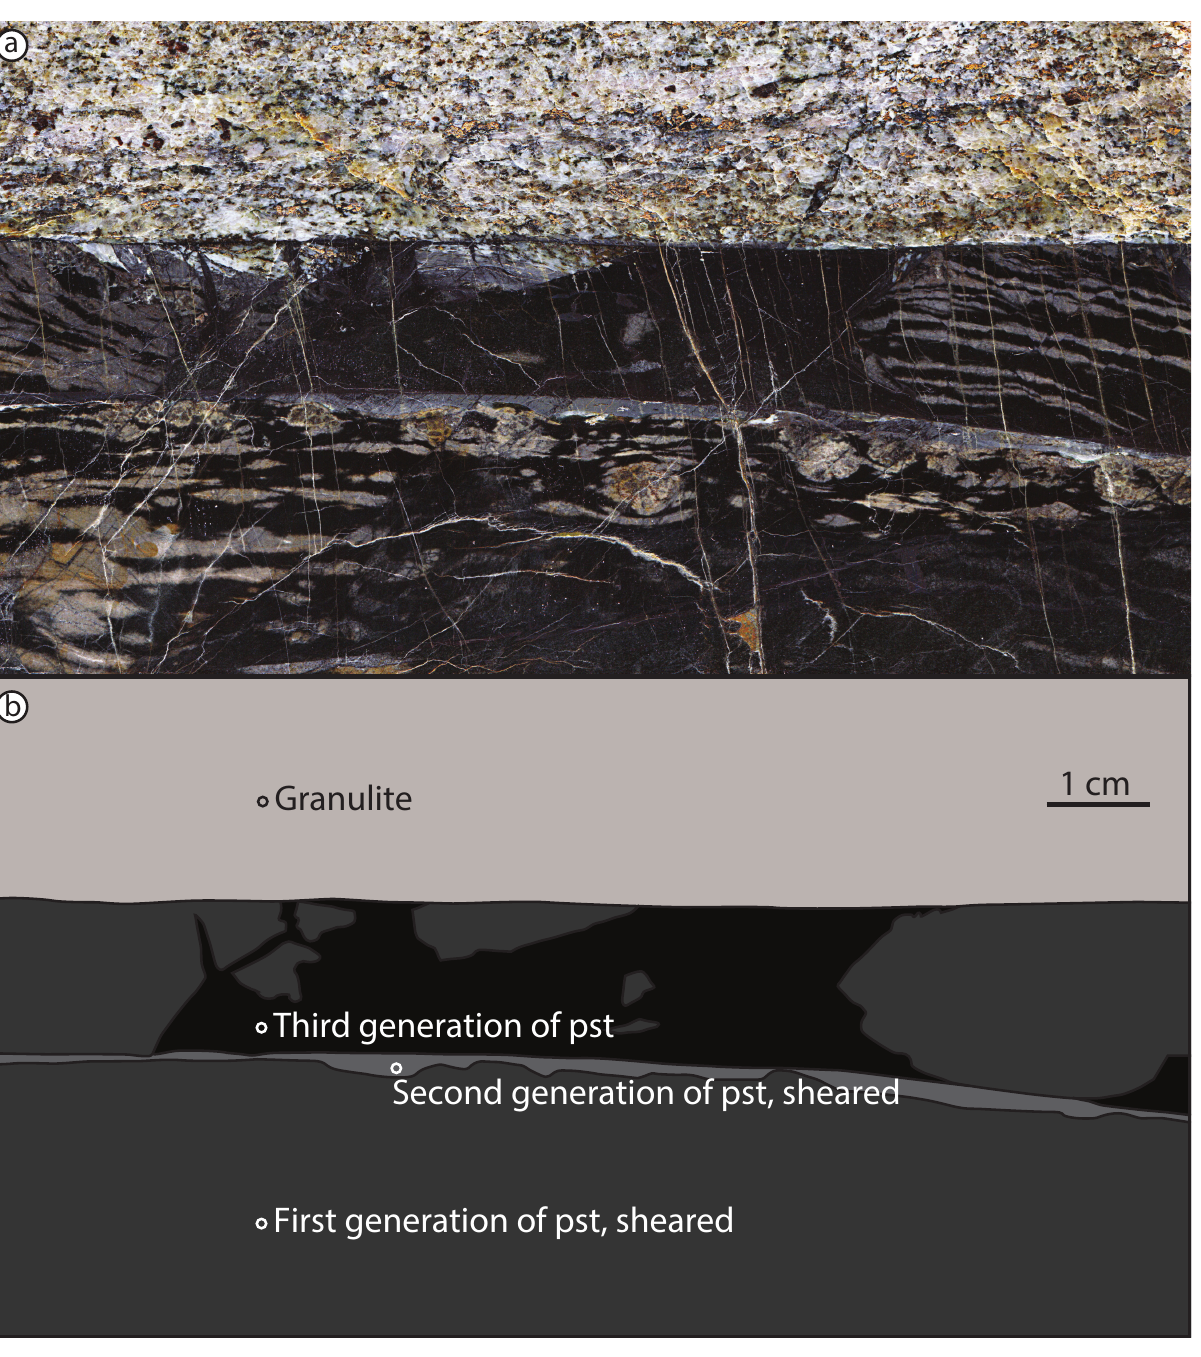
Figure 6. (a) Scan of a polished rock slab (sample F31; 26.2793S, 131.4968E), and (b) sketch of the same area. The sample shows three generations of pseudotachylyte, developed at the boundary between garnet-bearing quartzo-feldspathic gneiss (to the top) and a dolerite dyke (below and outside the image). The first generation of pseudotachylyte contains clasts of the quartzo-feldspathic host (upper part of the image), which are intensively sheared. This generation is cross-cut by a second generation of pseudotachylyte, which is present as a light grey vein, with much smaller clasts, which are also elongated. The third generation of pseudotachylyte exhibits a sharp boundary to the host rock in the upper part of the image and incorporates clasts of the first generation